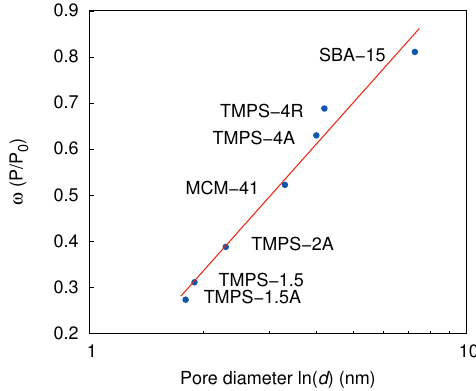
Figure 10. ω as a function of a natural logarithm of the mean pore size. Solid line represents the linear